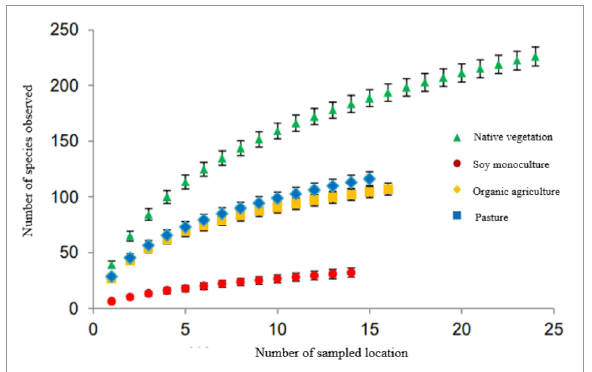
Figure 3: Accumulated number of ant species by sampled locations with the respective standard deviation based on data collected between May 2019 and August 2020 in the Rashad District.